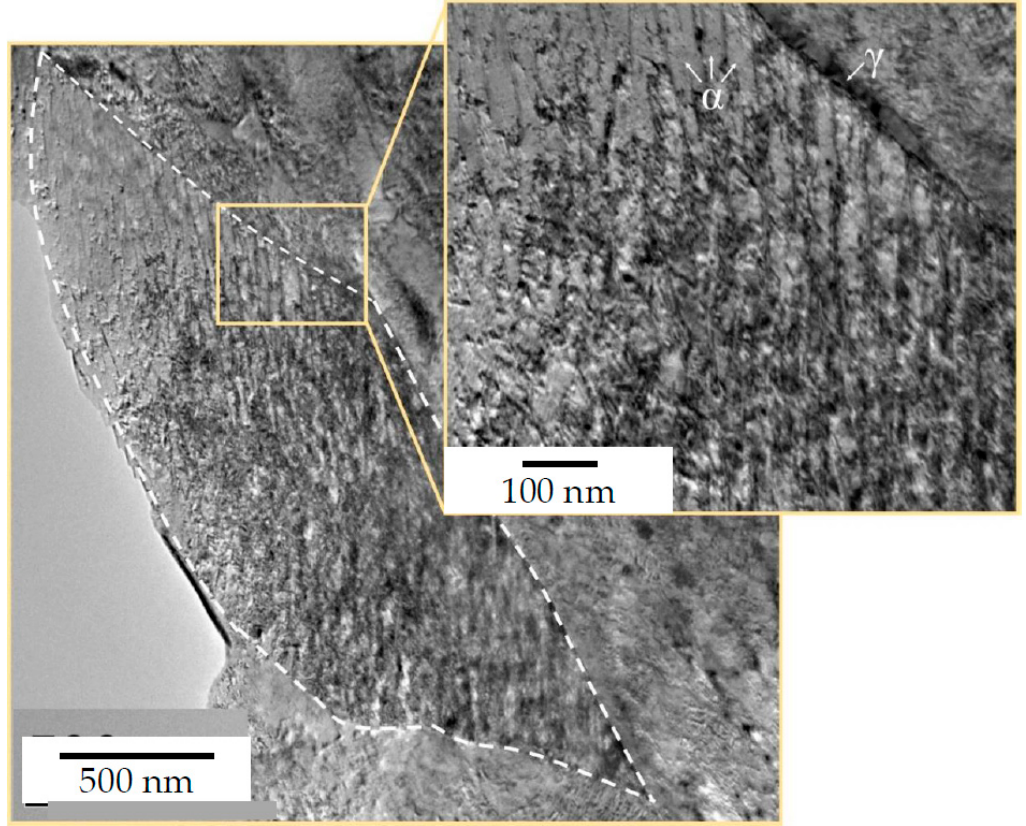
Figure 5. HRTEM Micrograph of the steel after intercritical annealing/heat treatment route ② , showing a single sheave of bainite, with a typical lenticular morphology; when observed in bright field mode, the bainitic ferrite plates ( α ) appear light, and the retained austenite ( γ ) dark. The retained austenite initially present has later been shown to decompose, resulting in some remarkably fine structures, as can be seen in Figure 6. The main benefit is that it does provide an